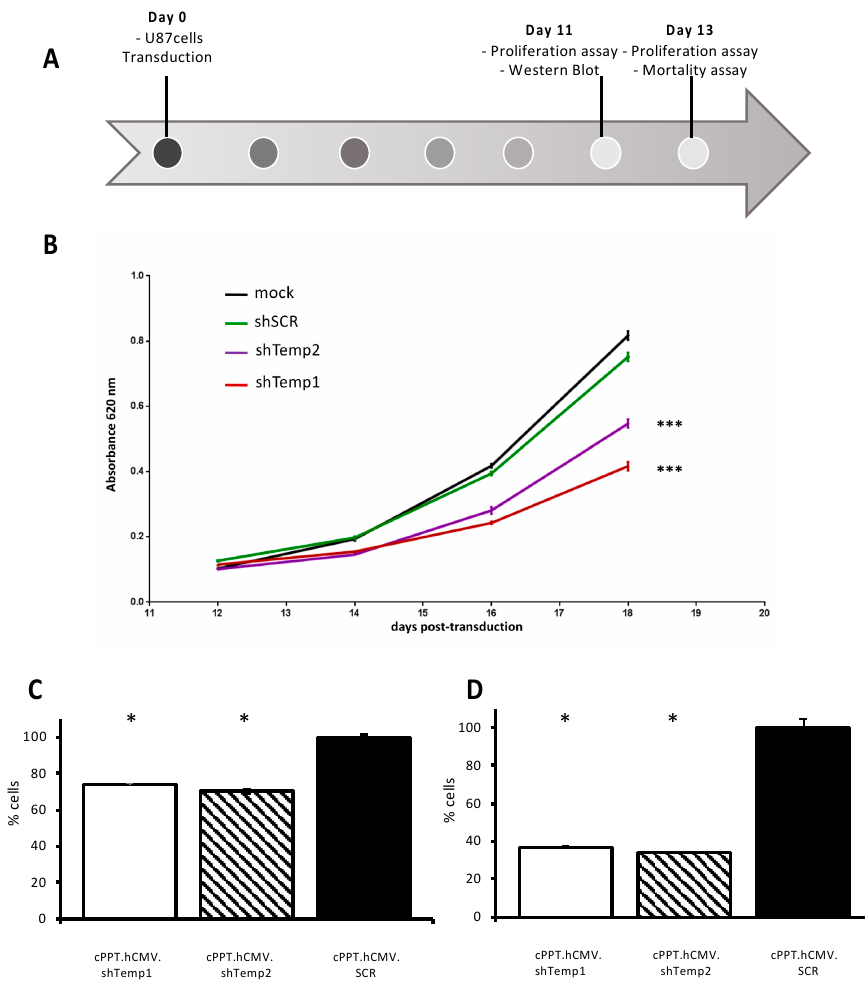
Figure 4. Effect of PKA silencing on U87 cells proliferation. ( A ) Timeline of transduction experiments in U87 cells. ( B ) MTT cell viability curves of U87 cells transduced with equivalent RT units of the lentiviral particles. On day 11, transduced U87 cells were processed for Western blot analysis of PKA R2A downregulation and seeded for MTT evaluation of cell growth. MTT assays were performed on day 12, 14, 16, and 18 post-transduction. Linear regression analysis of cell viability curves: shSCR versus shTemp1 and shTemp2: *** p < 0.001. ( C , D ) Analysis of proliferation of U87 cells 11 ( C ) and 13 ( D ) days after transduction. A significant reduction in cell number compared to scramble is present already 11 days post-transduction; * p < 0.05 versus scramble (black